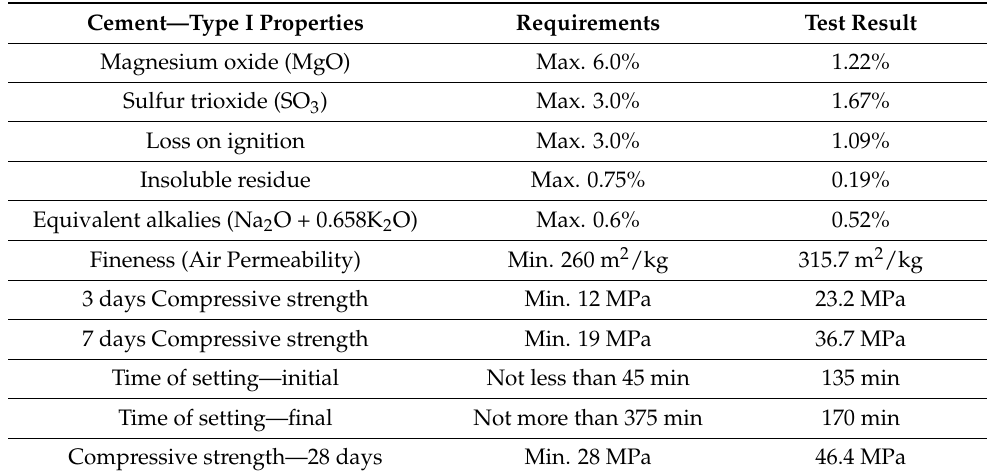
Table 2. Properties, requirements and test results for cement according to ASTM C 150 [30]. Cement—Type I